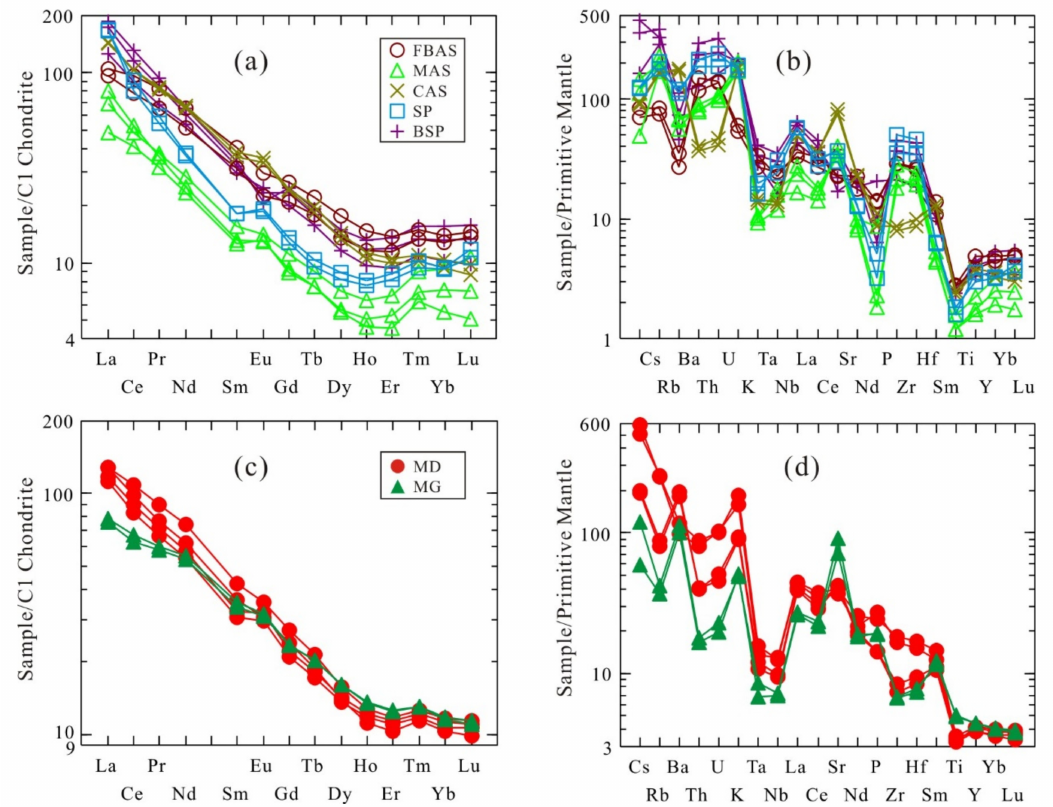
Figure 8. ( a , c ) Chondrite-normalized REE patterns for the Hongshan complex; ( b , d ) Primitive mantle-normalized trace element patterns. Chondrite and PM values are from Reference